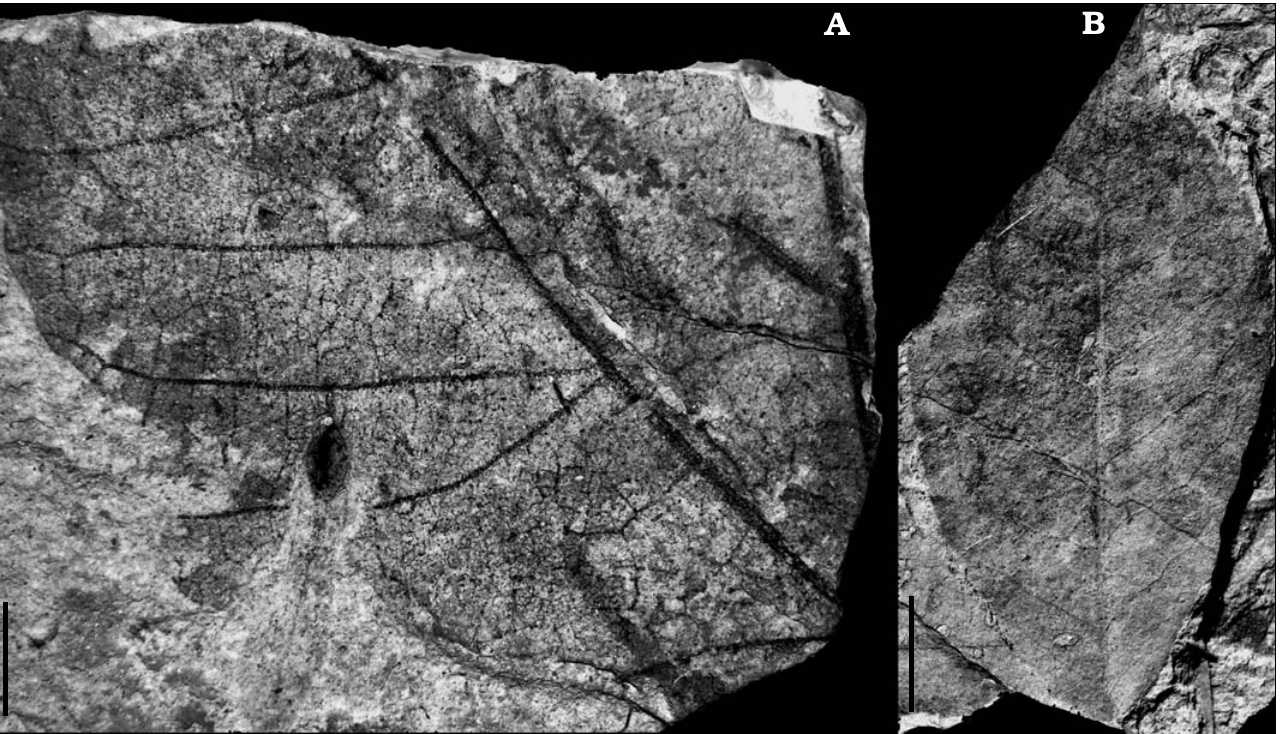
Fig. 8. Angiosperms impressions from Ł ysa Góra near R ę biszów, Poland, late Oligocene. A . Dombeyopsis lobata Unger, 1850, KRAM-P 128/462, leaf. B . cf. Rosa ligni tum Heer, 1869, KRAM-P 128/401, leaf. Scale bars 5